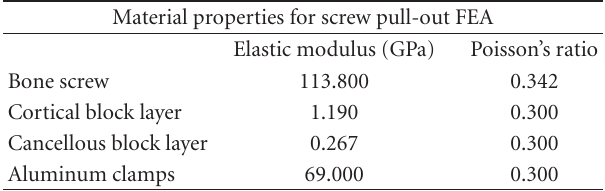
Table 1: Material properties used in the numerical analysis of the screw